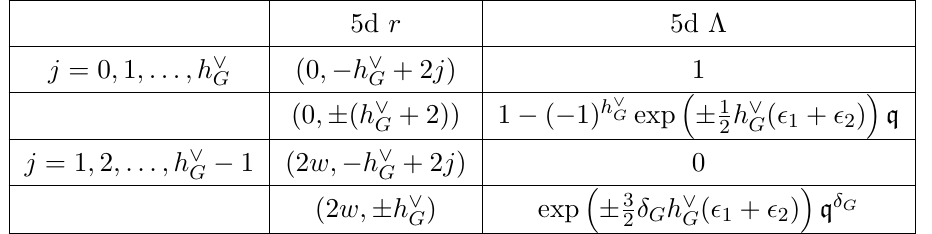
) , with weight m G , r log q ) . , r log Q G ell